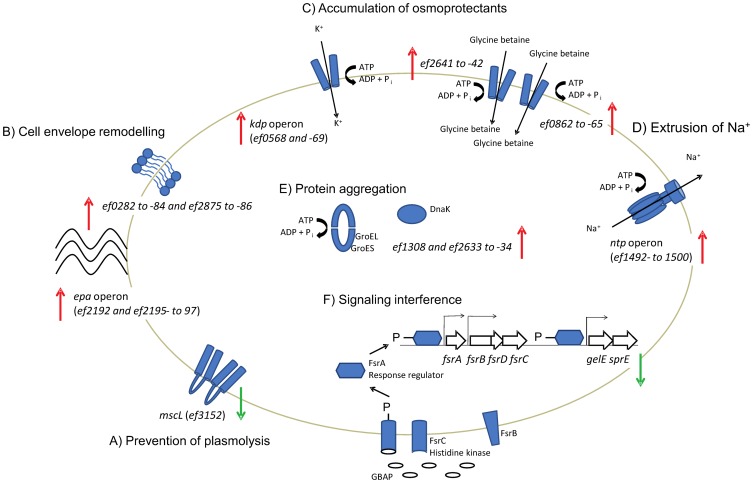
An overview of the main constituents of the E. faecalis response to high NaCl concentrations.Among the responses observed was an immediate down-regulation of mscL to prevent plasmolysis (A), accompanied by an up-regulation of genes involved in the adjustment of membrane properties (B) and an up-regulation of genes involved in uptake of osmoprotectants (C). The main mechanism for extrusion of excess Na+ appeared to be the V-type ATPase encoded by the ntp operon (D). An up-regulation of genes coding for the molecular chaperone DnaK and GroEL/ES is indicative of NaCl-induced aggregation and misfolding of proteins (E). Finally, the exposure to NaCl also resulted in a strict repression of the gelE-sprE operon. Follow-up experiments established that this regulation was due to salt interfering with the receptor-pheromone interaction of the Fsr quorum sensing system (F). Significantly regulated genes are given in parenthesis when only parts of an operon were significantly differentially expressed.